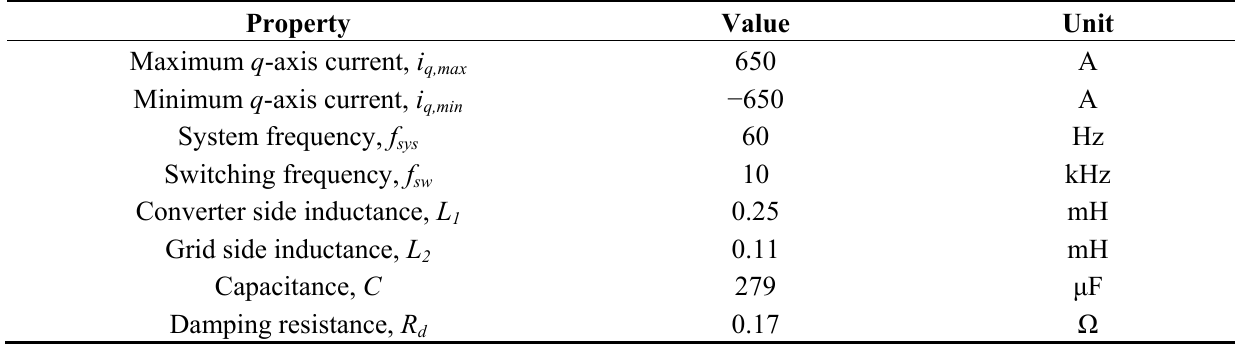
Table 2. Parameters of the DG.